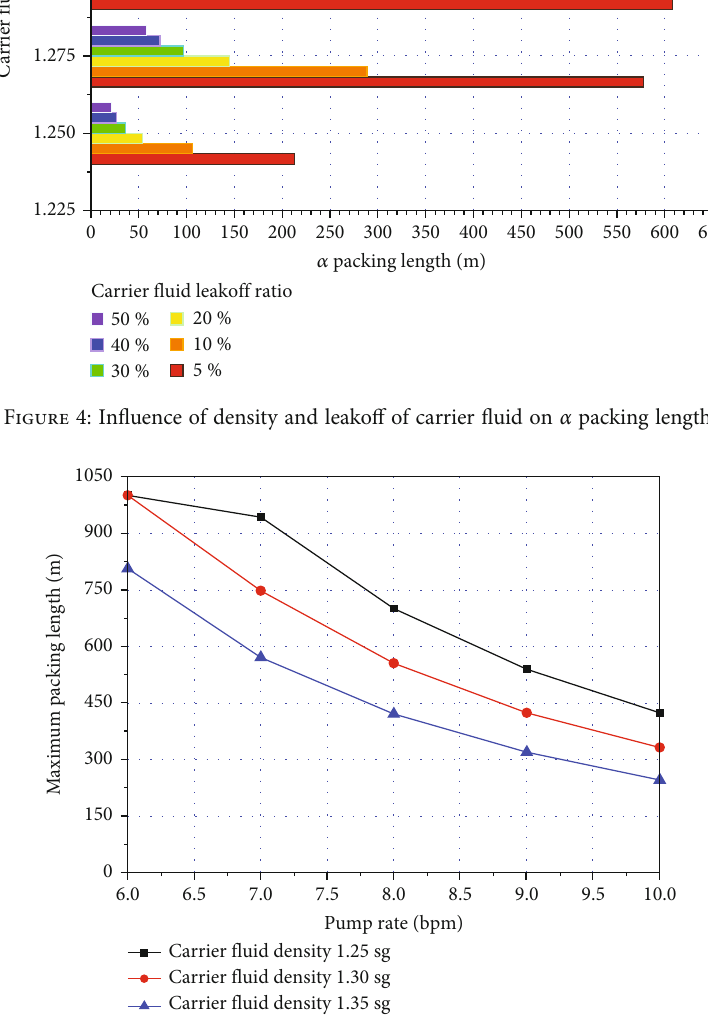
Figure 5: In fl uence of pump rate and fl uid density on maximum packing